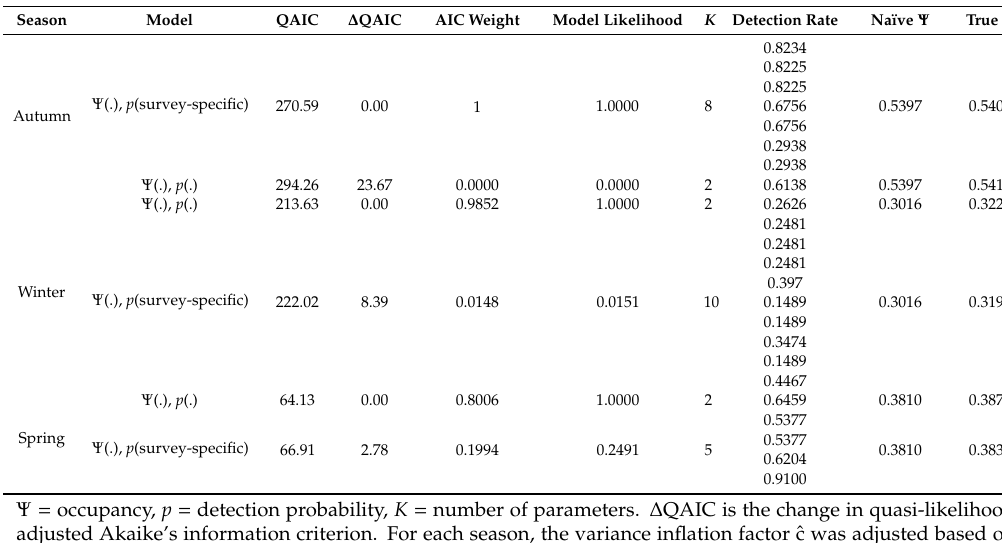
Figure 2. The proportion of all gardens surveyed (n = 26 in Week 1 and n = 63 for Weeks 2–20) where hedgehogs were recorded each week. Weekly survey dates are given in the format dd/mm , running from November 2017 to April 2018 inclusive. Table 2. Summary of baseline hedgehog occupancy models where detection rate was modelled as constant (did not vary between weeks within each season) versus survey specific (did vary between weeks within each season). Seasons are illustrated in Figure